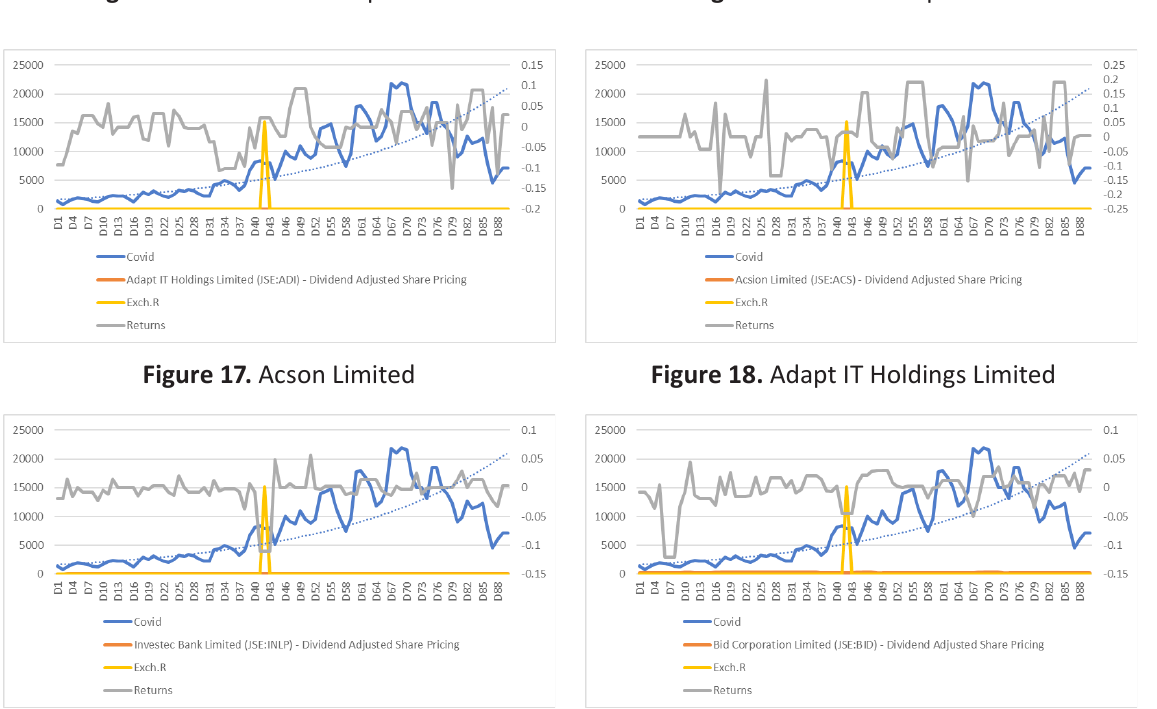
Figure 19. Investec Bank Limited Figure 20. Bid Corporation